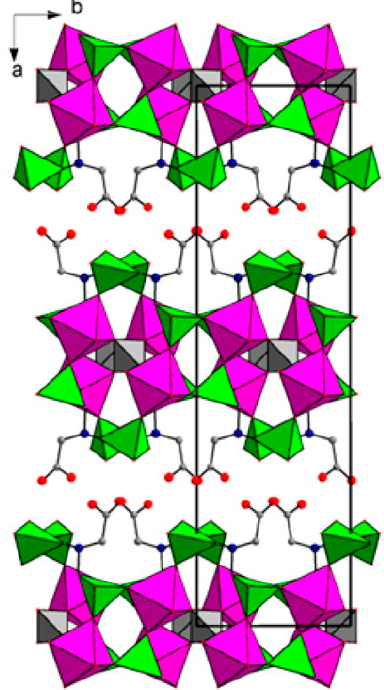
Figure 22. Crystal structure of Zr 2 (PO 4 )H 5 [(O 3 PCH 2 ) 2 NCH 2 COO] 2 ·H 2 O viewed along the c -axis. Colour code: zirconium: pink, phosphorus: green, oxygen: red, nitrogen: blue, carbon: grey. Reprinted with permission from reference. [107]. Copyright 2014, American Chemical Society.